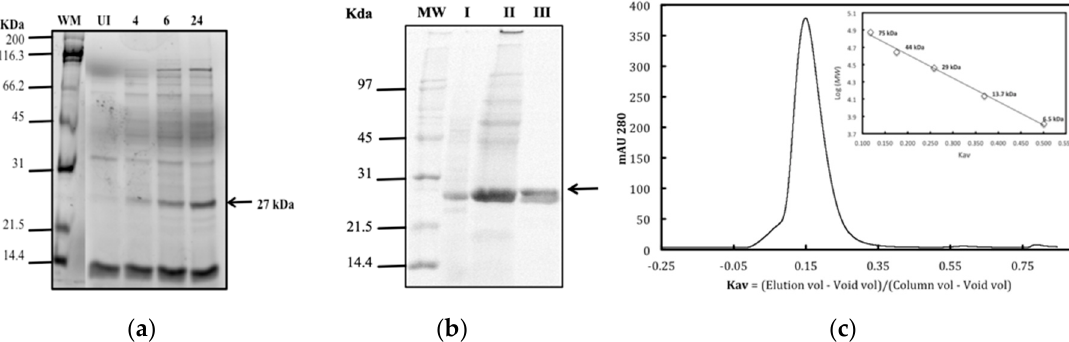
Figure 4. SDS-PAGE of LvFSH purified by two chromatographic methods. ( a ) MW: molecular weight marker. UI, not induced, and 4, 6, 24 h post-induction with 1 mM IPTG. 0.3 M NaCl; ( b ) SDS-PAGE purification of LvFSH by chromatography methods chromatography, MW Molecular Weight Marker Broad Range (Bio-Rad). I, crude extract; II elute with 23% of imidazole 500 mM Ni +